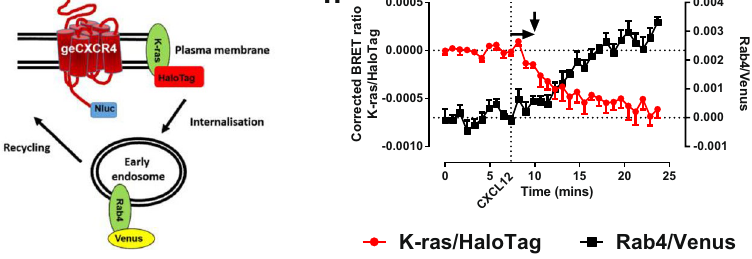
This approach may be useful for monitoring interactions with proteins expressed at even lower levels if homozy- gosity is achieved. It should also be noted that without generation of homozygous clones, responses observed in the cells generated here will still have the potential to be influenced by the presence of untagged protein. The cellular environment can influence protein signalling as well as localisation/compartmentalisation, and will differ between cell types, thus protein-protein interactions are likely the sum of the cellular components. Ideally protein-protein interaction studies would be performed in cell types relevant to their function rather than model cell lines as used here, however CRISPR/Cas9 homology-directed repair is most efficient in dividing cells, with non-dividing cells more likely to undergo non-homologous end joining 50 . Thus homology-directed repair in primary cells with limited culture life or non-dividing cells is challenging 51 . However, investigating interactions with a luciferase-fused protein of interest in such models could conceivably be achieved by: CRISPR/ Cas9-mediated generation of knock-in pluripotent stem cells 52 that could be further differentiated to study inter- actions in the cell type of interest; using cells obtained from, or the use of, knock-in animals 28 ; or engineering